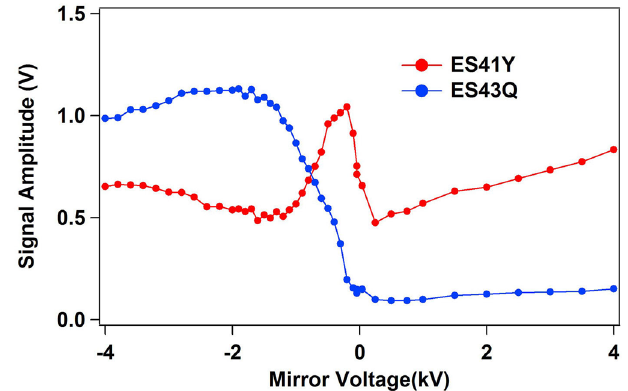
FIG. 16. (Color) Mirror voltage scan showing the prompt signal amplitudes from the quadrupole diagnostic (ES43Q) and the drift space diagnostic (ES41Y) as a function of voltage (kV) applied to the electron